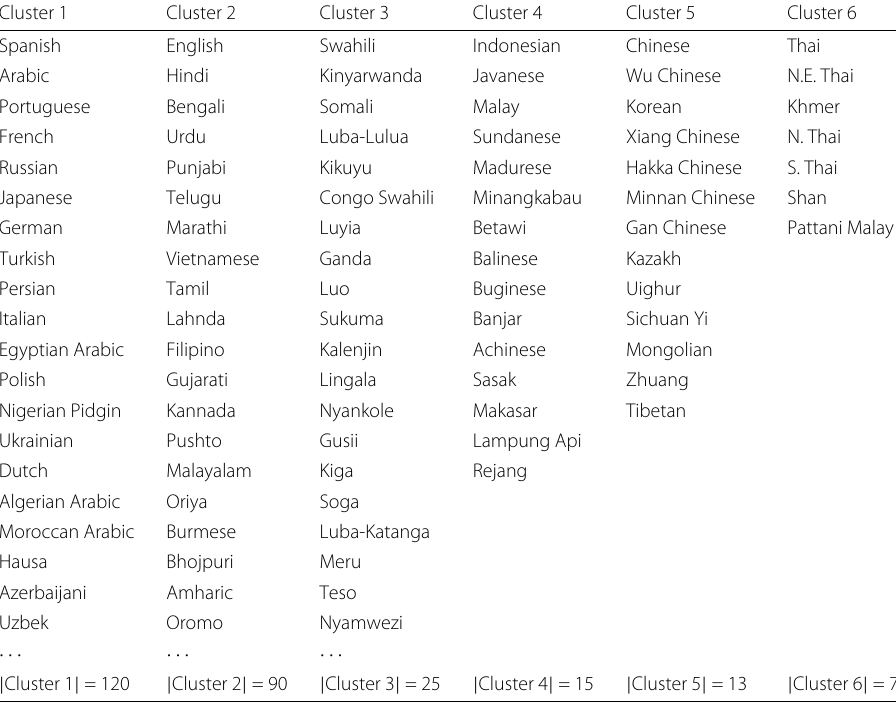
Table 4 Clustering the languages from the U NICODE -L ANGUAGES network using the mean-weighted expander